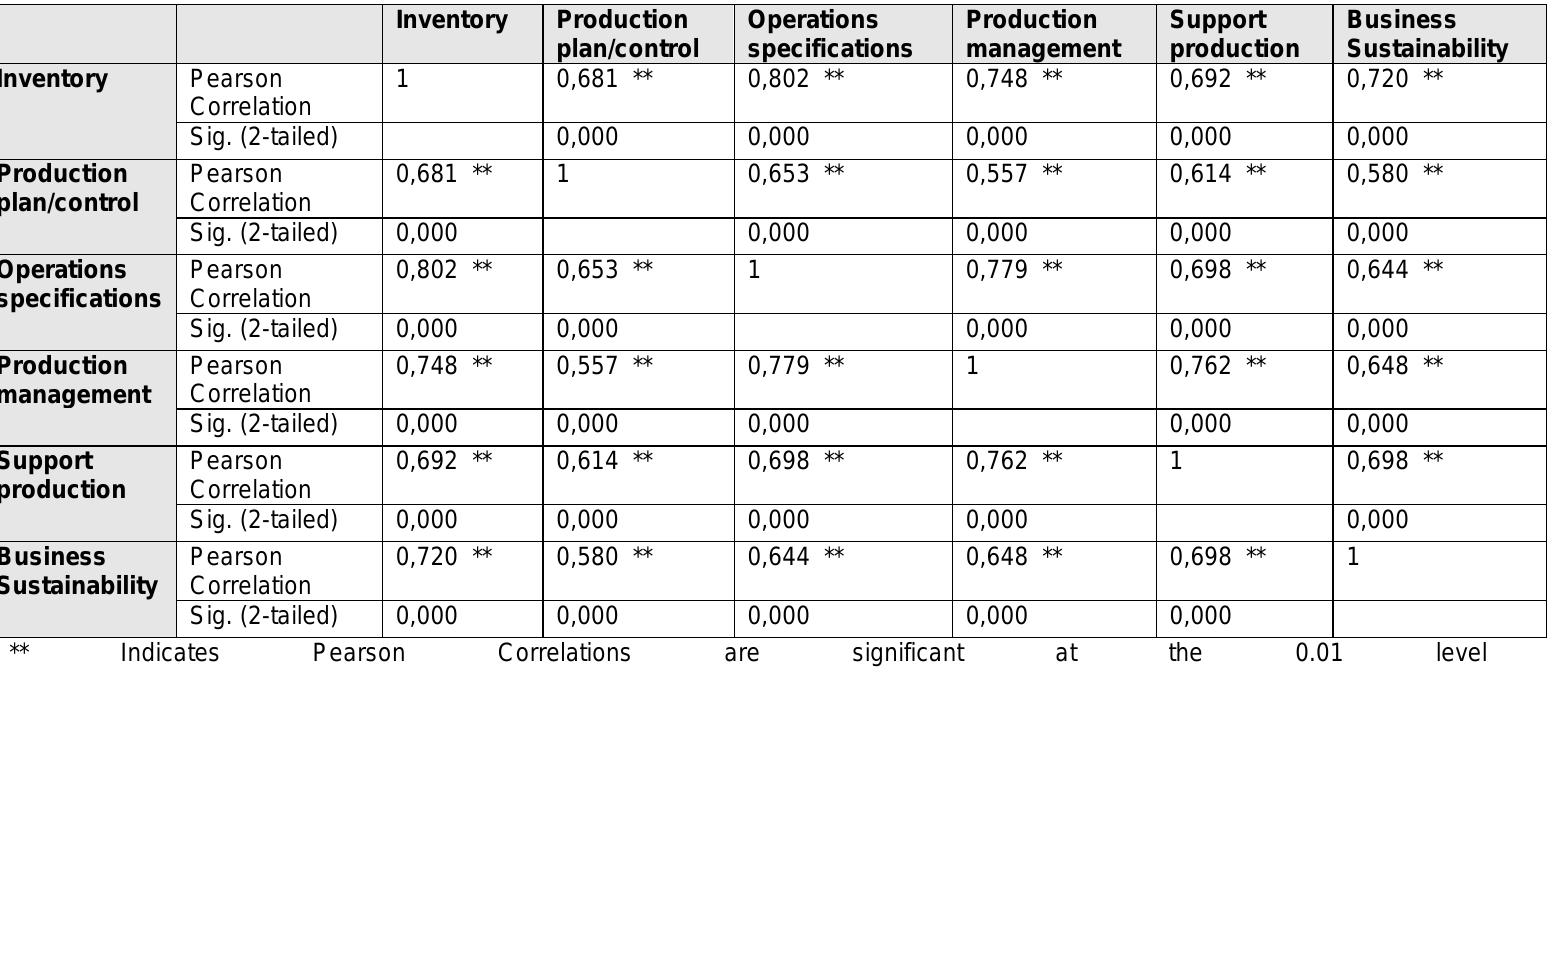
Table 5: Correlations matrix for operations factors and SMME